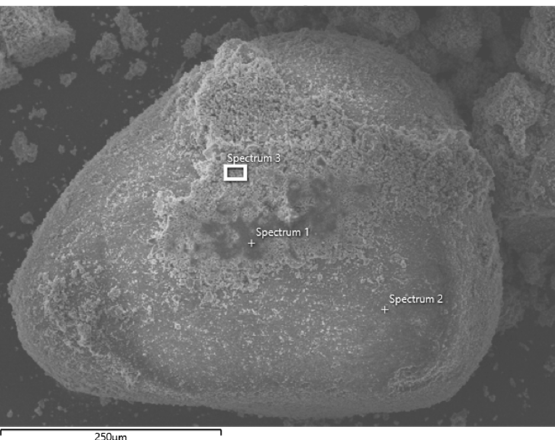
Figure 8. ZK1 microstructure prepared in magnification of: ( a ) 1000×; ( b ) 500×.